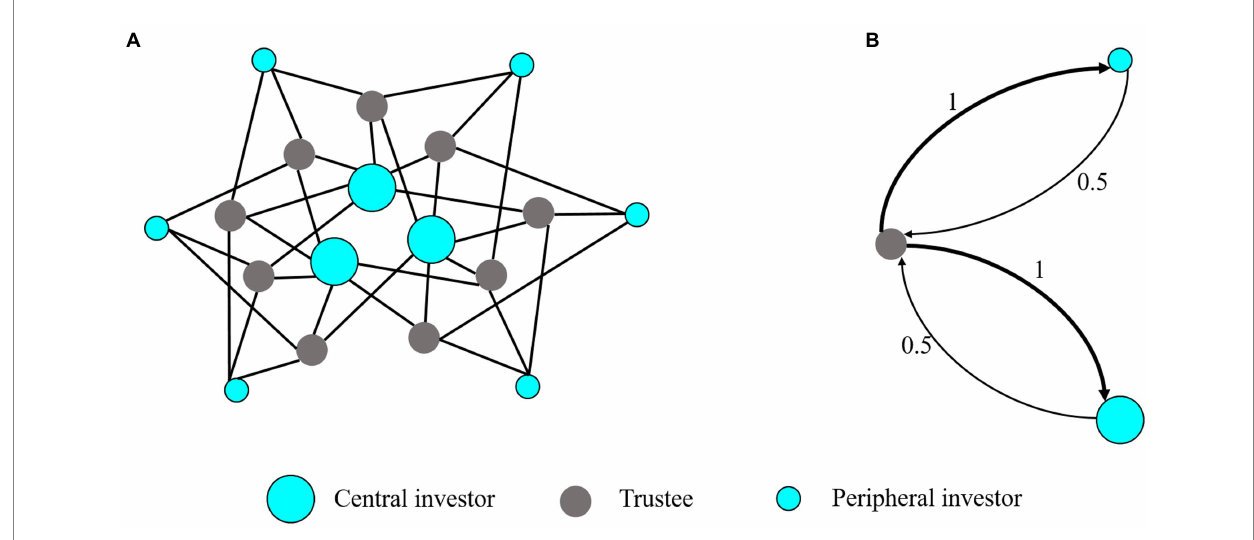
FIGURE 5 Network structure and mean-field approximation of the trust game. (A) The network structure of TG. The network has three central investors each connecting to six trustees; six peripheral investors, each connecting to three trustees, and nine trustees each connecting to four investors. (B) The mean-field approximation of the TG network. The simplified system consists of three (types of) nodes, a trustee, a peripheral investor, and a central investor, representing three typical players in the network. The afferent arrows represent interaction with the neighbors of nodes. The thickness of the arrow and the value on the arrow represents the connection link weight.